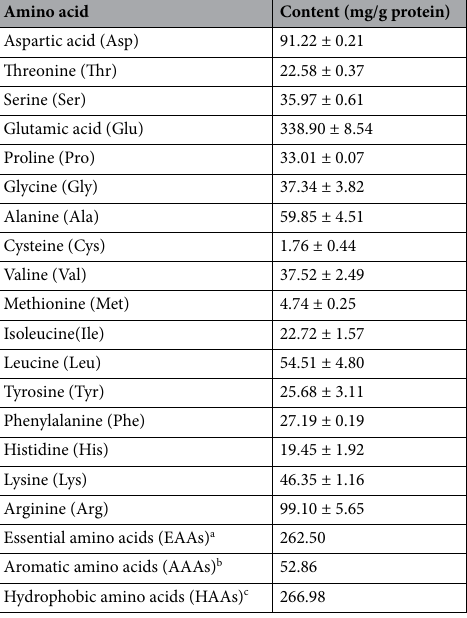
Table 5. Total amino acid compositions of jasmine rice bran protein hydrolysate obtained at optimum condition. a EAAs are Thr, Cys, Val, Met, Ile, Leu, Tyr, Phe, His and Lys. b AAAs are Phe and Tyr. c HAAs are Ala, Val, Ile, Leu, Tyr, Phe, Pro, Met and